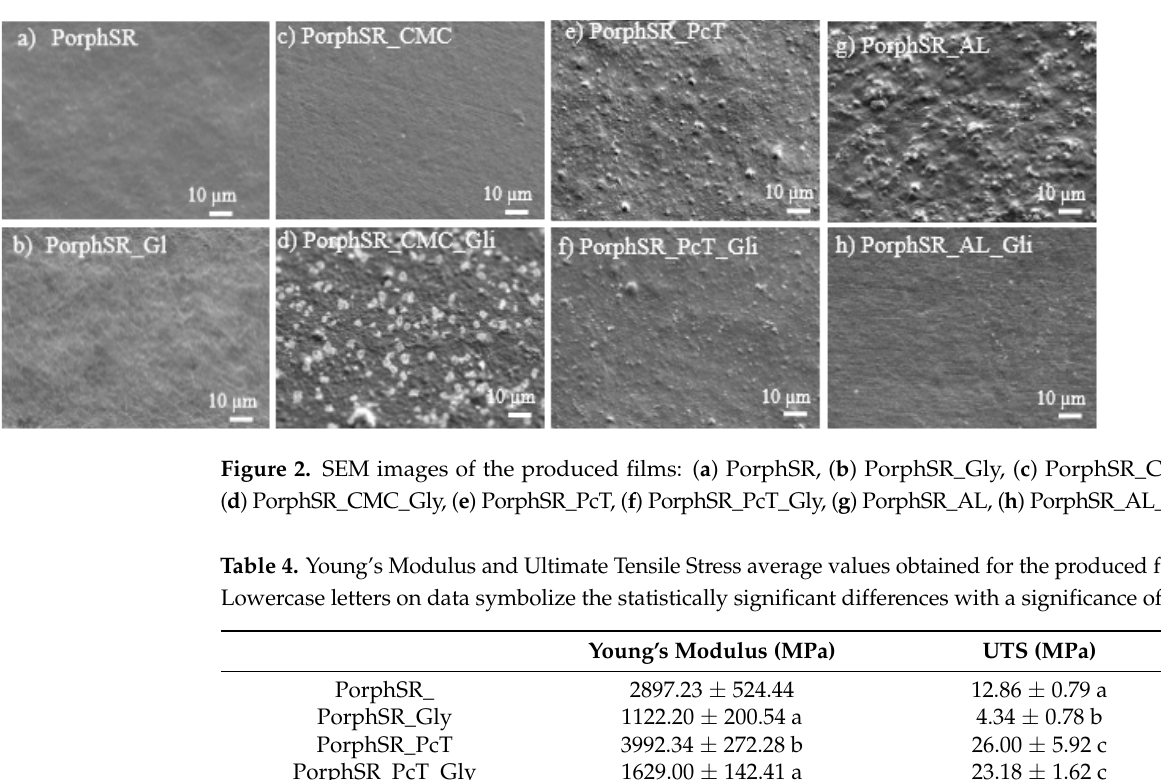
Table 4. Young’s Modulus and Ultimate Tensile Stress average values obtained for the produced films. Lowercase letters on data symbolize the statistically significant differences with a significance of 5%.